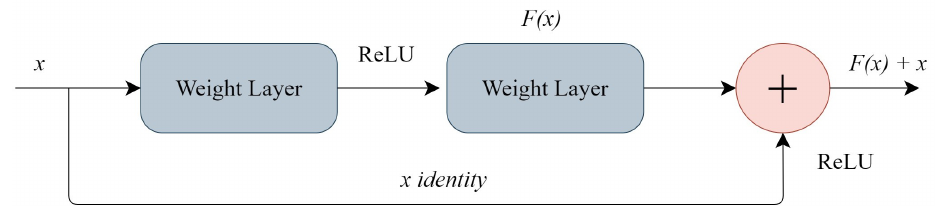
Figure 12. ResNet’s residual